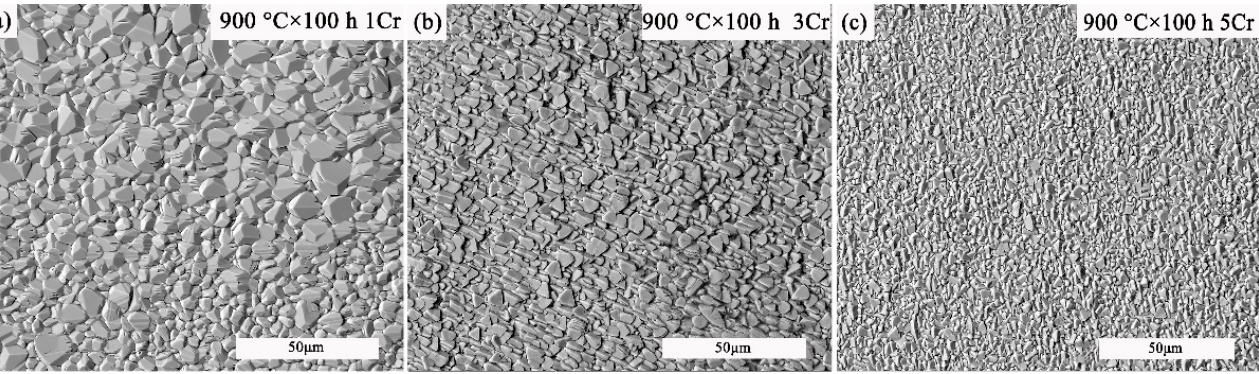
Figure 3. SEM micrograph of oxidized surface, ( a ) 1Cr 900 °C/100 h, ( b ) 3Cr 900 °C/100 h, ( c ) 5Cr 900 °C/100